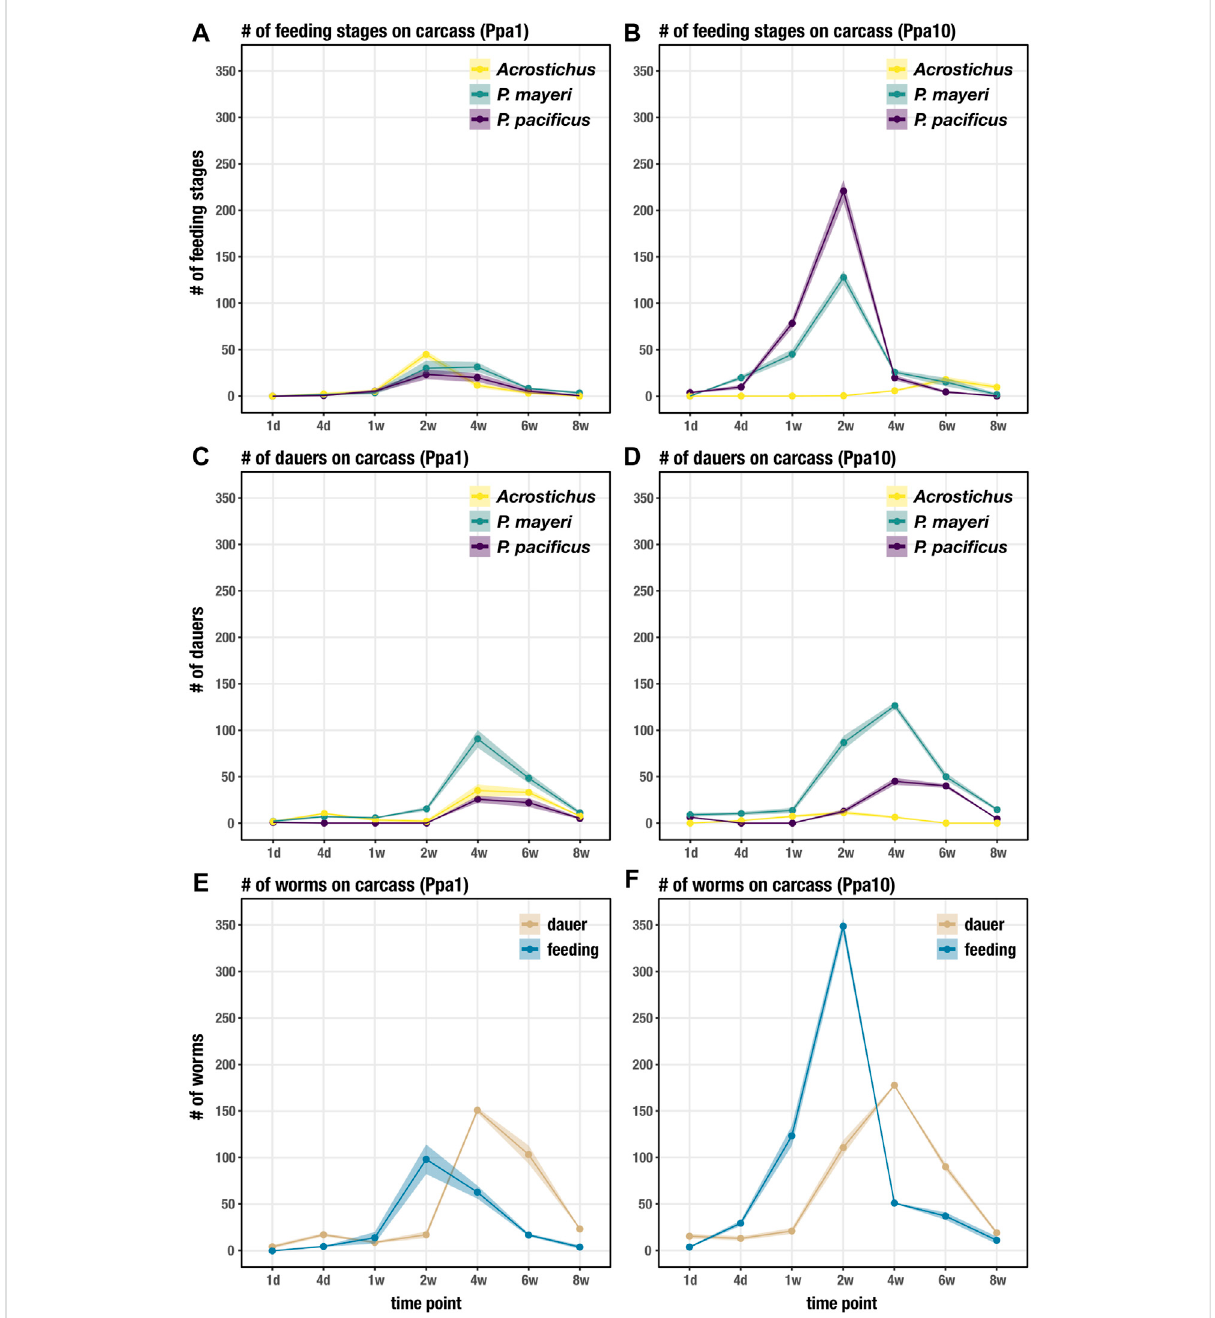
Succession of developmental stages on the beetle carcass over 8 weeks. (A) Succession of feeding stages of each species on Ppa1 carcasses over 8 weeks. (B) Succession of feeding stages of each species on Ppa10 carcasses over 8 weeks. (C) Succession of dauers of each species on Ppa1 carcasses over 8 weeks. (D) Succession of dauers of each species on Ppa10 carcasses over 8 weeks. (E) Succession of total feeding stages and dauers (the three species combined) on Ppa1 carcasses over 8 weeks. (F) Succession of total feeding stages and dauers (the three